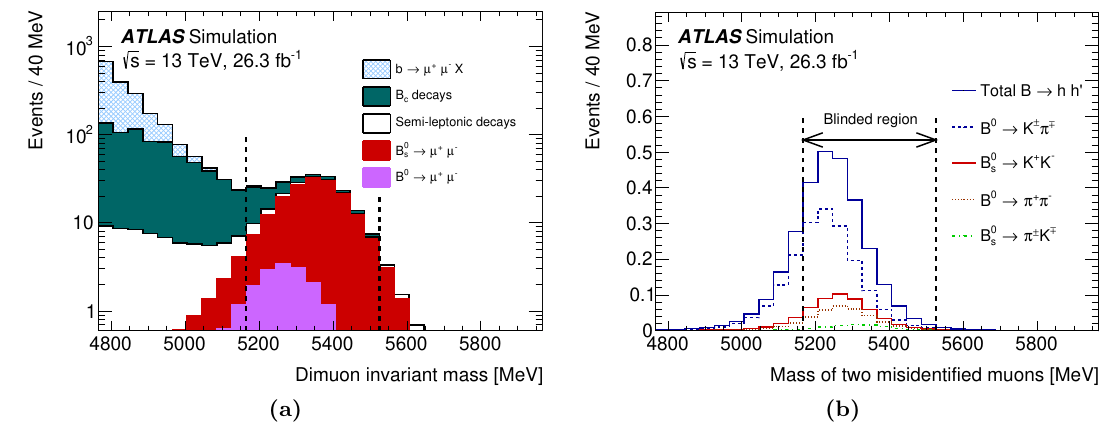
Figure 1. (a) Dimuon invariant mass distribution for the partially reconstructed background (as categorised in section 4), from simulation, before the (cid:12)nal selection against continuum is applied but after all other requirements. The di(cid:11)erent components are shown as stacked histograms, normalised according to world-averaged measured branching fractions. The SM expectations for the B 0 ! ( s ) (cid:22) + (cid:22) (cid:0) signals are also shown for comparison. Continuum background is not included here. (b) Invariant mass distribution of the B 0 ! hh 0 peaking background components after the complete ( s ) signal selection is applied. The B 0 ! (cid:25) + (cid:25) (cid:0) and B 0 ! K + K (cid:0) contributions are negligible on this s scale. In both plots the vertical dashed lines indicate the blinded analysis region. Distributions are normalised to the expected yield for the integrated luminosity of 26.3 fb (cid:0) 1 .